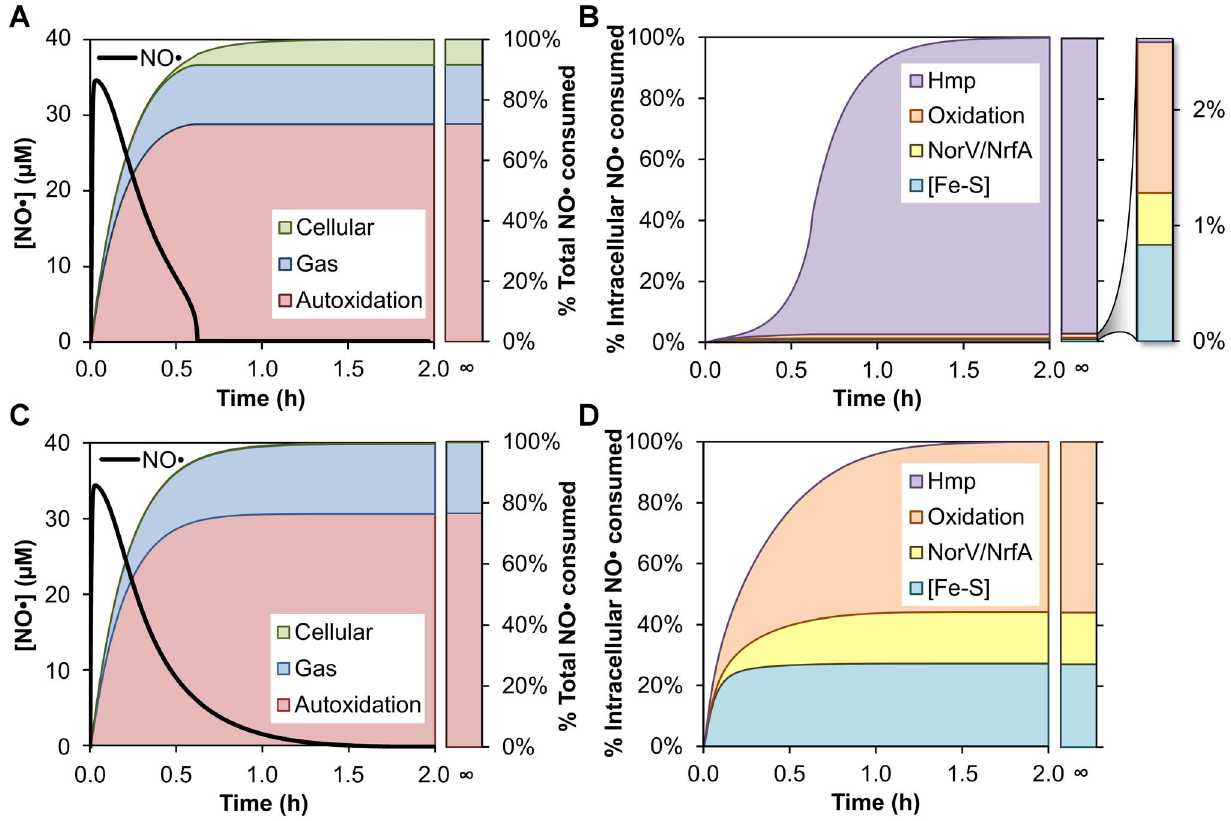
Figure 5. Increasing the NO N delivery rate alters the dynamics and distribution of NO N consumption. (A) Simulated NO N concentration curve (black line) and corresponding cumulative distribution of total NO N consumption in a wild-type culture following addition of 0.5 mM PAPA. (B) Predicted cumulative distribution of intracellular NO N consumption in a wild-type culture following addition of 0.5 mM PAPA. (C) Simulated NO N concentration curve (black line) and corresponding cumulative distribution of total NO N consumption in a D hmp culture following addition of 0.5 mM PAPA. (D) Predicted cumulative distribution of intracellular NO N consumption in a D hmp culture following addition of 0.5 mM PAPA.